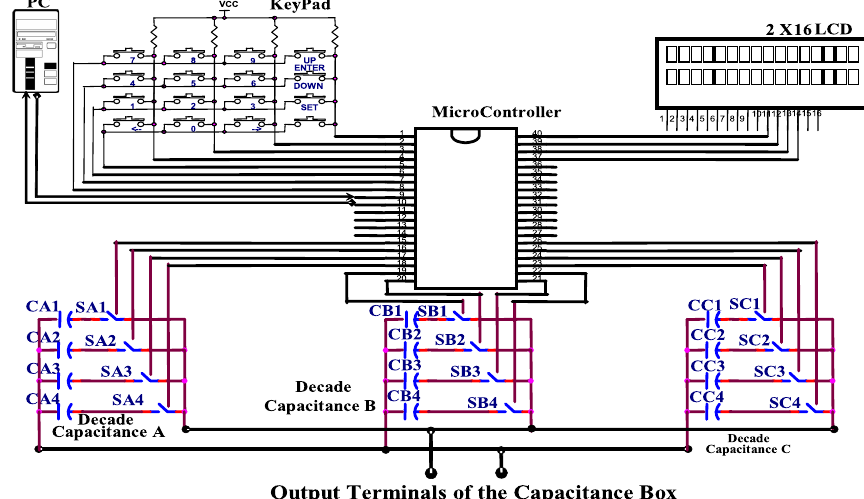
Fig. 1. Design of the fabricated